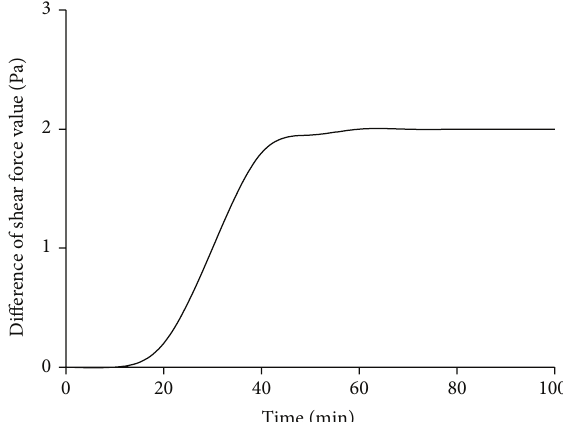
Figure 7: Thixotropy analysis of drilling fluid with